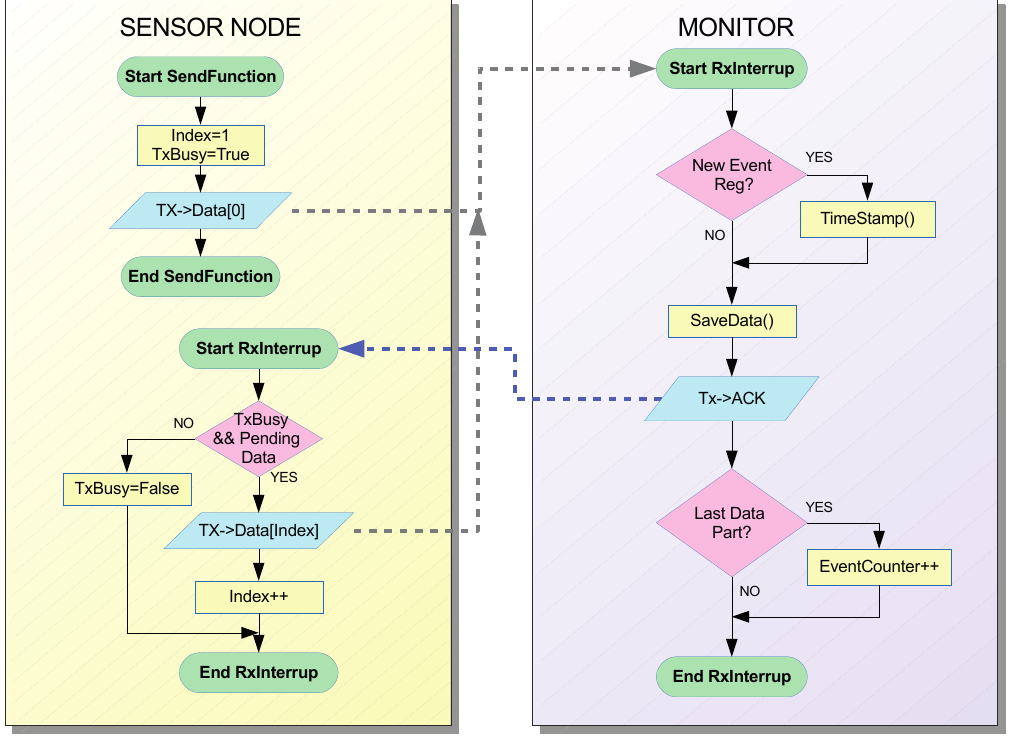
Figure 4. Flowchart of hybrid monitor